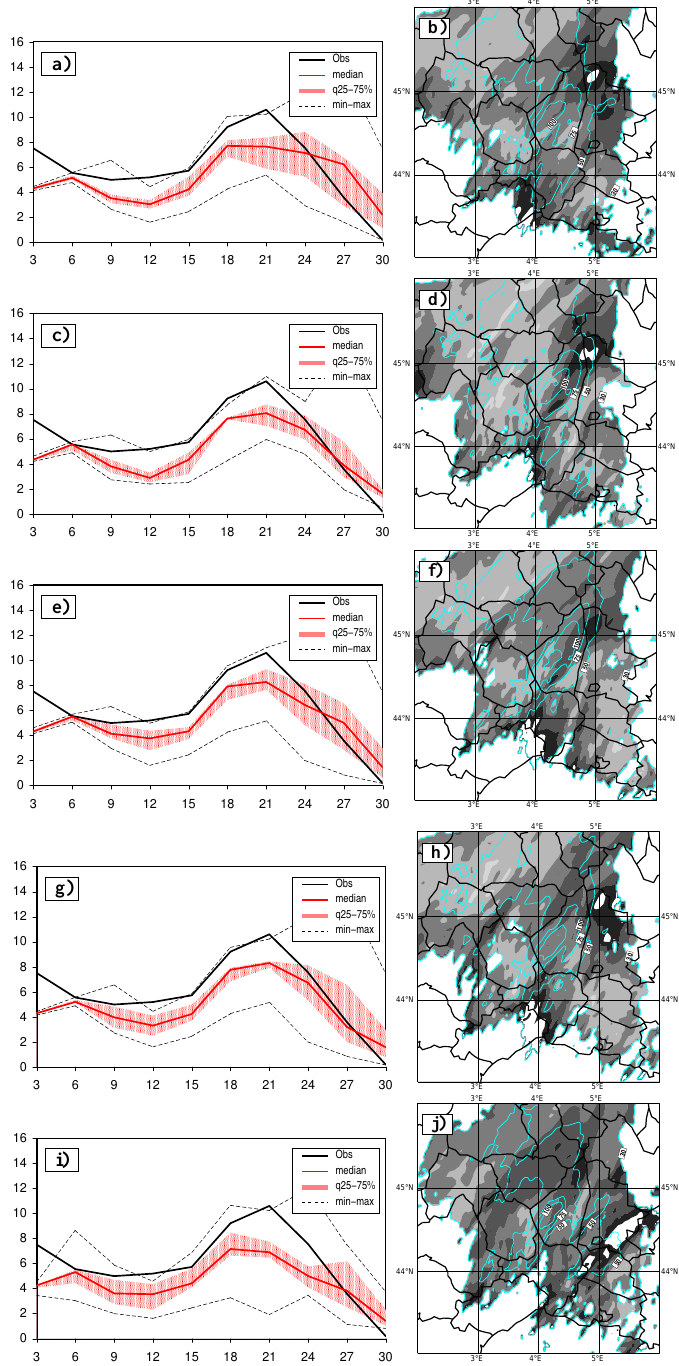
Fig. 13. Gard case time series of the 3-h surface precipitation averaged over the subdomain seen in Fig. 8 and the 24-h accumulated simulated precipitation ensemble-mean (solid lines) and the normalised spread (shading) for the RAND1 ( a and b ), RAND2 ( c and d ), CLUST-REF ( e and f ), CLUST-MOIST ( g and h ), and LAG ( i and j ) ensemble experiments. Interquartile ranges (25%–75%), minimum, maximum and medians are shown. The accumulation 24-h period starts on 7 September 2010 at 00:00UTC and ends on 8 September 2010 at